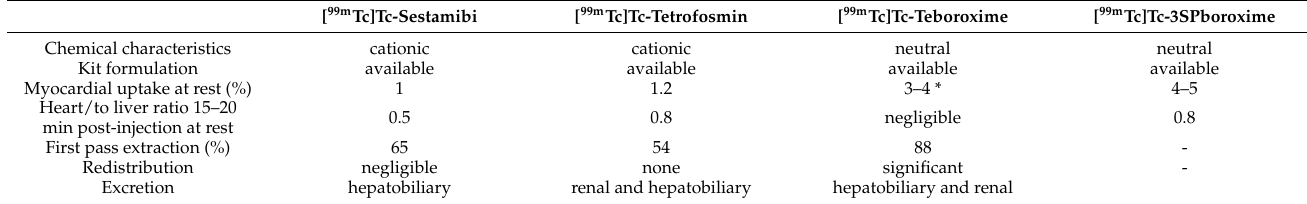
Table 1. Properties of selected 99m Tc-labeled MPI